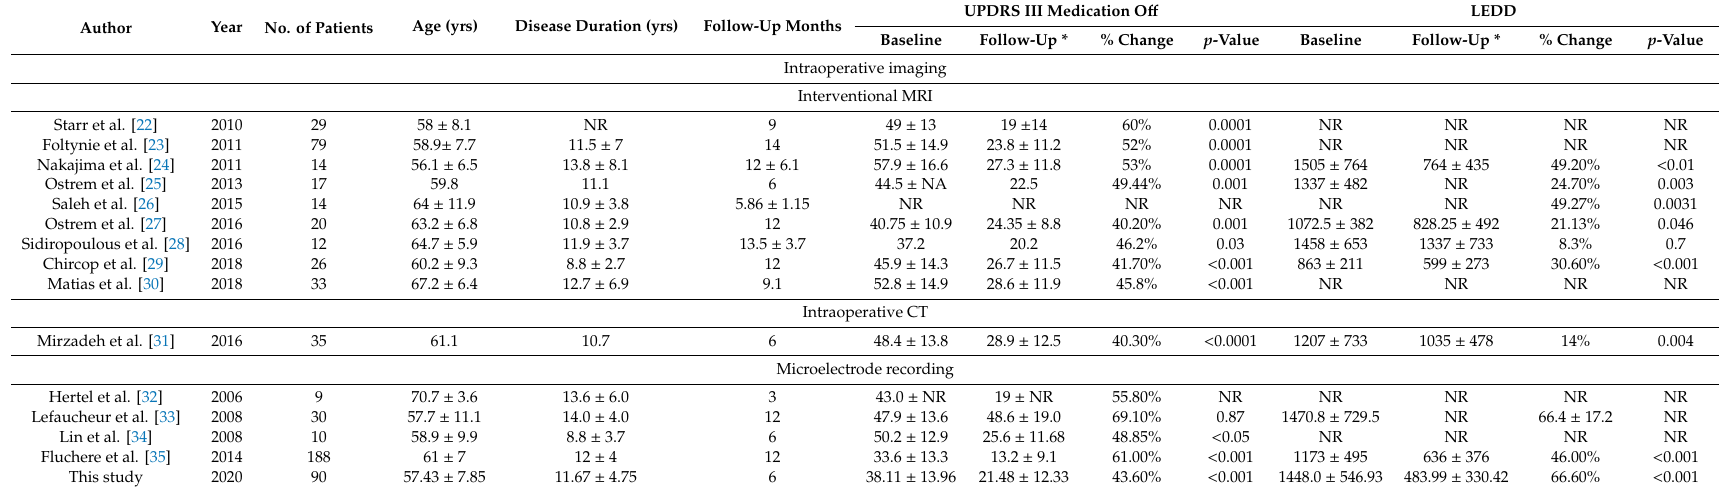
Table 1. Summary data of published literature presenting clinical outcome e ff ect of after subthalamic nucleus deep brain stimulation under general anesthesia in patients with Parkinson’s